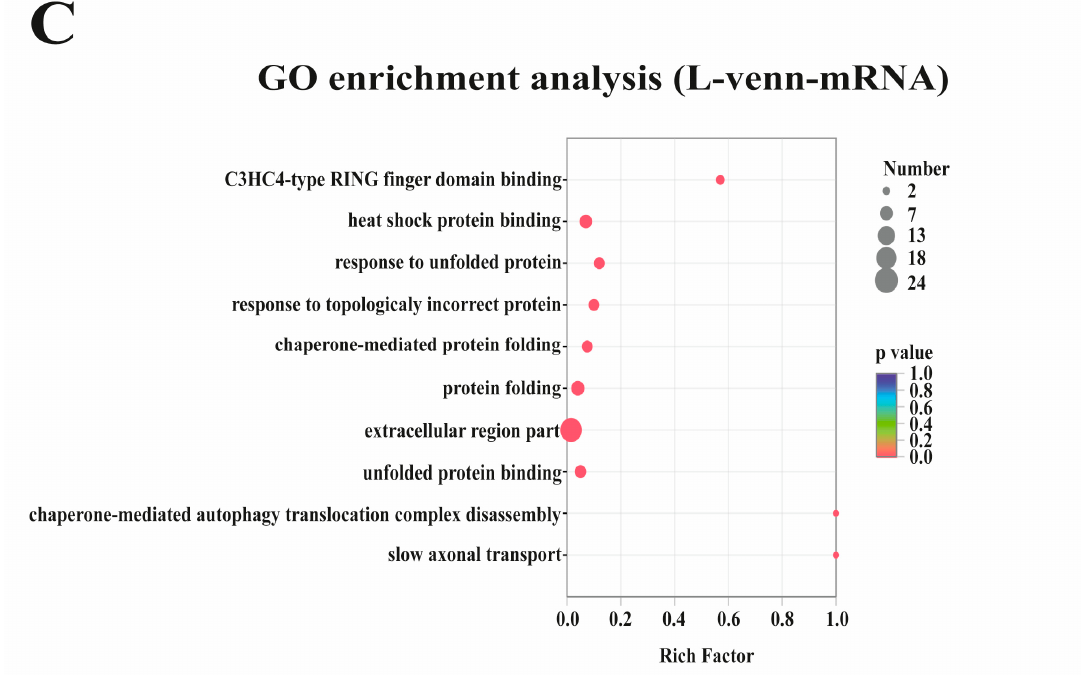
Figure 3. Venn diagram of common ( A ) DEmRNAs and ( B ) DElncRNAs during four stages by three closed groups and two consecutive groups, and distribution diagram of enriched Gene Ontology (GO) functions of ( C ) common DEmRNAs.